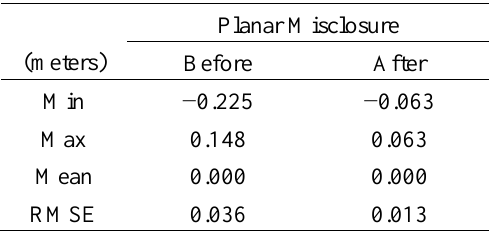
Table 3. Misclosures Statistics Before and After